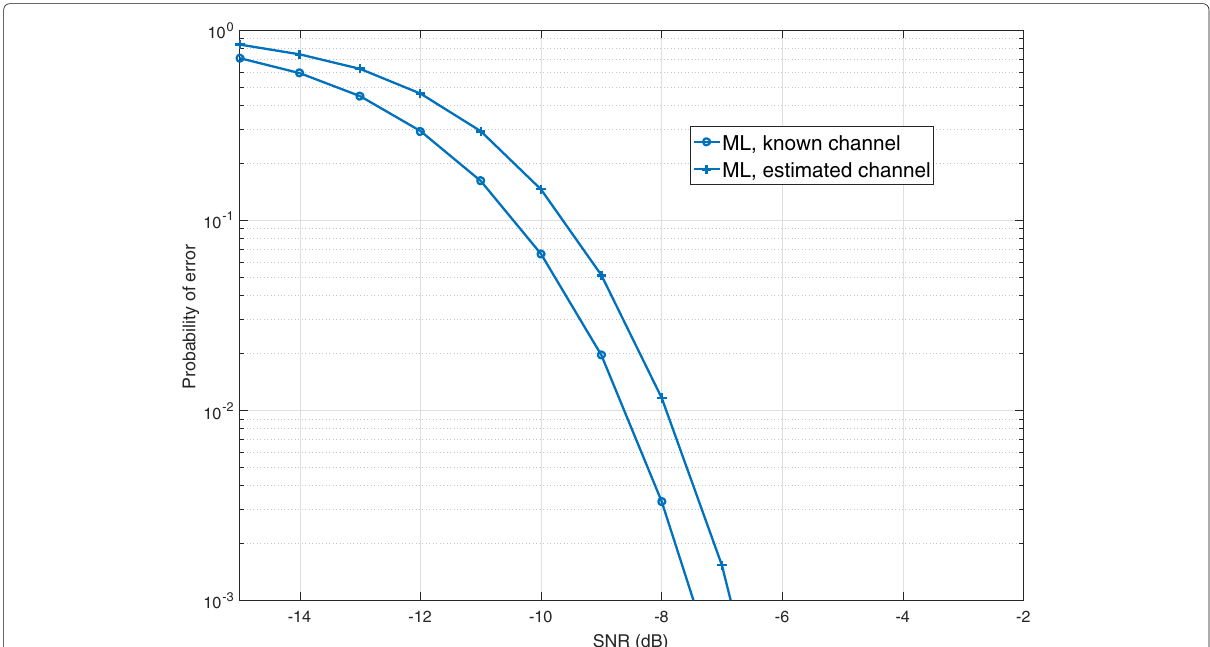
Fig. 5 Error probability versus SNR (dB) of cell ID ML estimator using the suggested DFT-based implementation with channel estimation